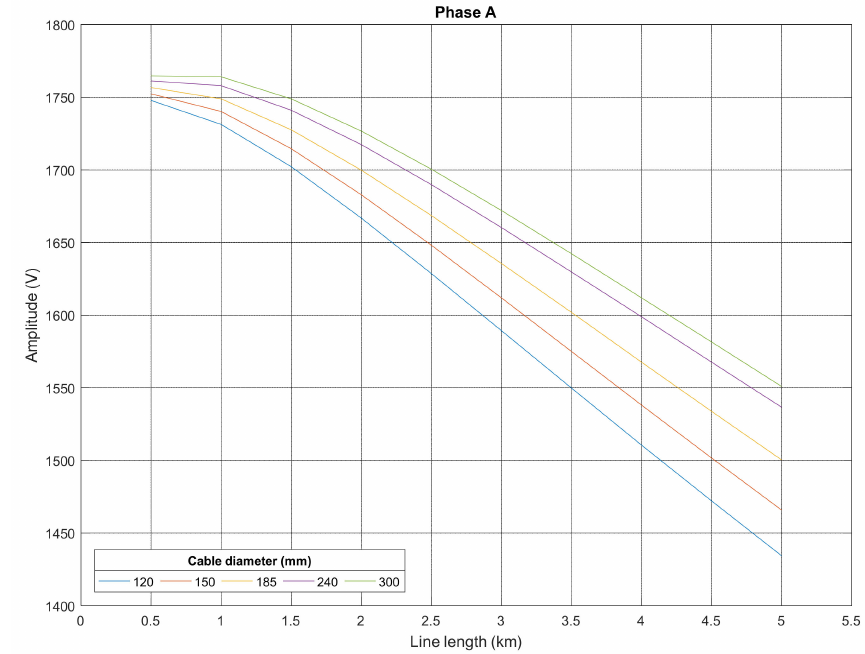
Figure 9. Maximum overvoltage in Terminal J for different conductor cross-sections and lengths in phase